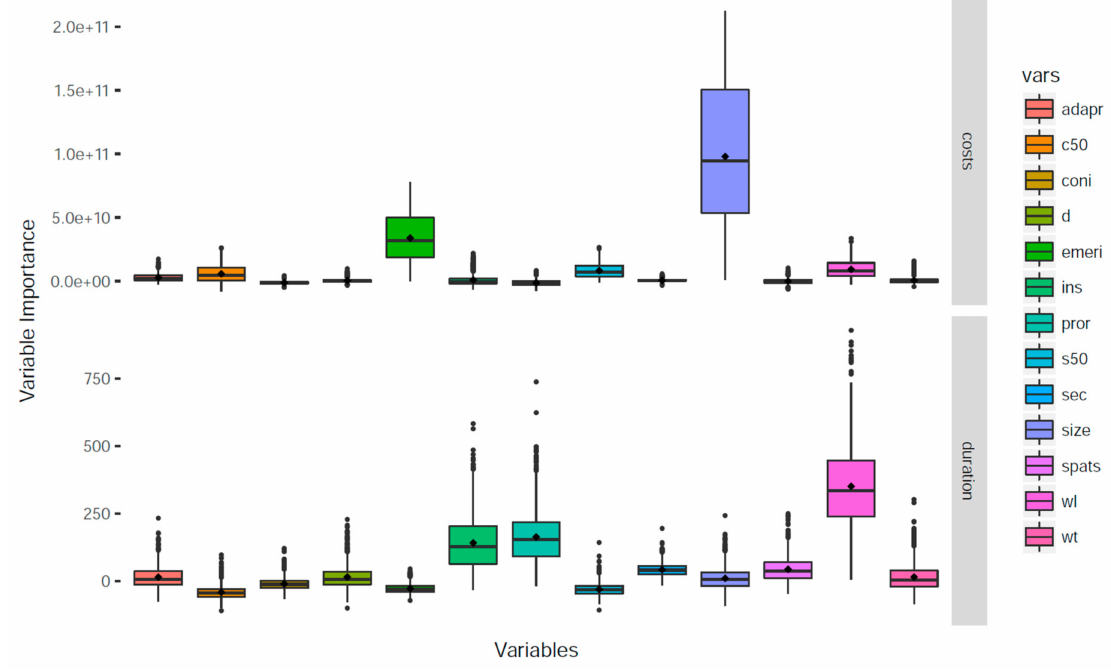
Figure 6. Box plots of predictor variable importance. The variable importance distributions are derived from 1000 Random Forests trained with individually sampled